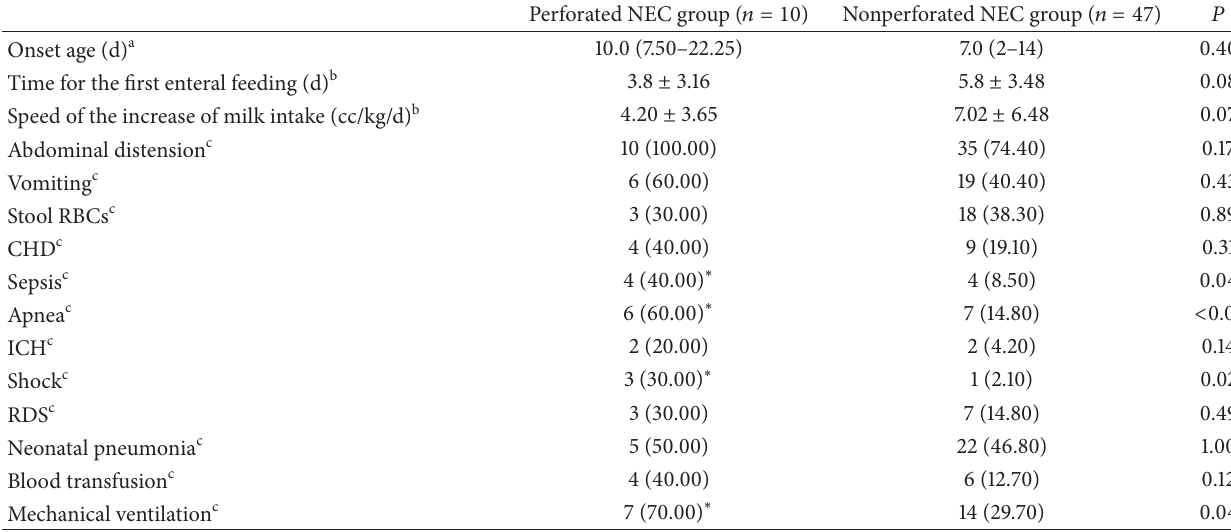
Table 2: Clinical characteristics in NEC infants with and without bowel perforation.